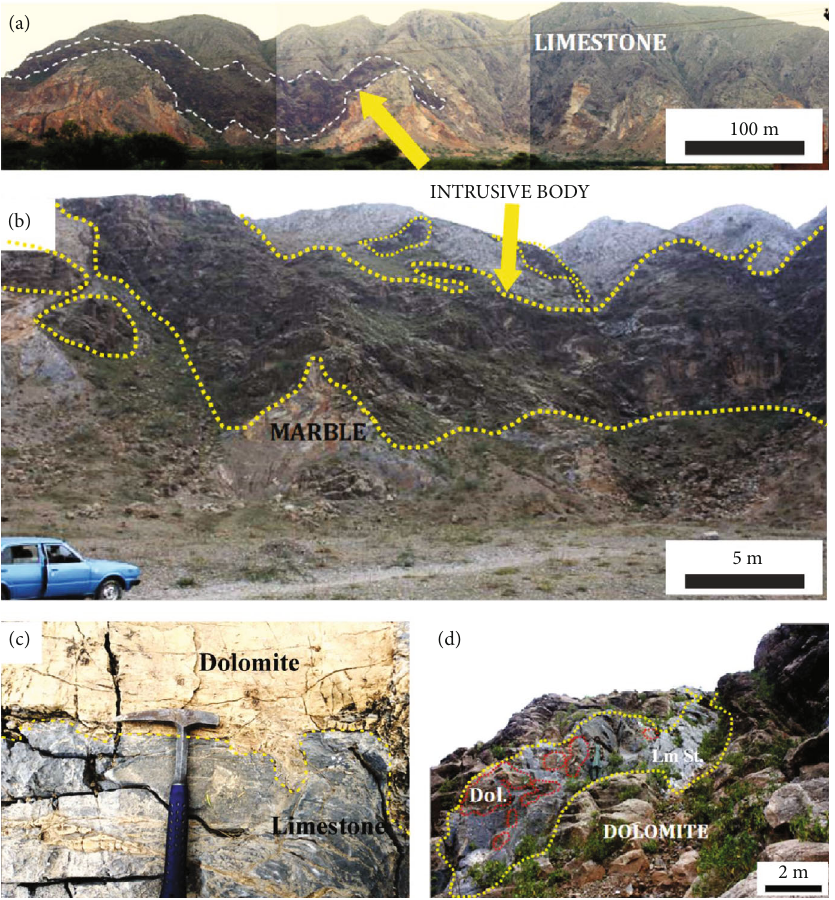
Figure 3: Field photographs of host rock (limestone) and igneous intrusions in the study area. (a) Panoramic view of the outcrop showing the distribution of dolerite intrusions in the Khyber Limestone succession shown by white dotted line. (b) Close-up view of a dolerite dyke intrusion in the Khyber limestone marked by yellow dotted line. Note that the marble is formed due to contact metamorphism phenomena. (c) Sharp contact between limestone-dolomite units in the formation. (d) Isolated block of limestone shown by yellow dotted line within the dolerite intrusion, surrounded by light brown-colored